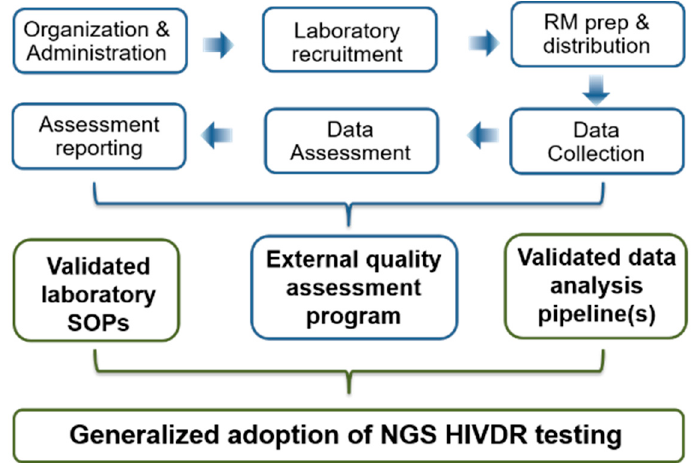
Figure 1. Essential requirements for the generalized adoption of NGS HIVDR assays and the key logistical components for a supportive EQA program. (Abbreviations: RM: Reference Materials; SOPs: Standard Operating Procedures; NGS: Next-Generation Sequencing; HIVDR: HIV Drug Resistance).